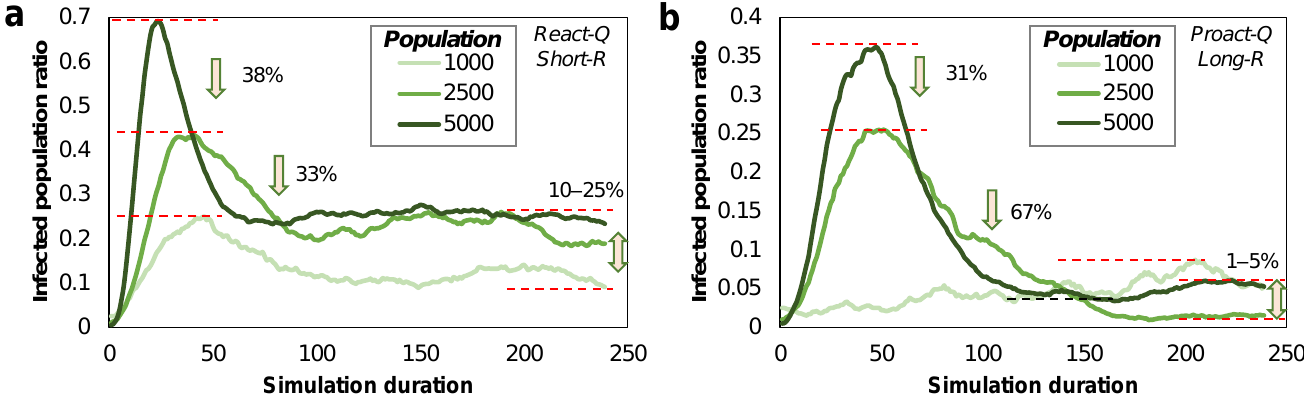
Figure 8. The impact of the population density on the evolution of epidemic outbreaks measured by φ ( t ) . Note that density is proportional to the population size N , as we keep the simulation space S fixed. ( a ) A reactive quarantine policy and a short recurrence determine high infection ratios in the population (up to ψ = 0.68). A final, residual infection rate of 10–25% remains until the end of the simulation time. ( b ) A proactive quarantine policy and a long recurrence determine relatively lower infection ratios (up to ψ = 0.36). A final, residual infection rate of 1–5% remains until the end of the simulation time. The decreases in the peak infected ratio are shown as relative percentage for each population size N